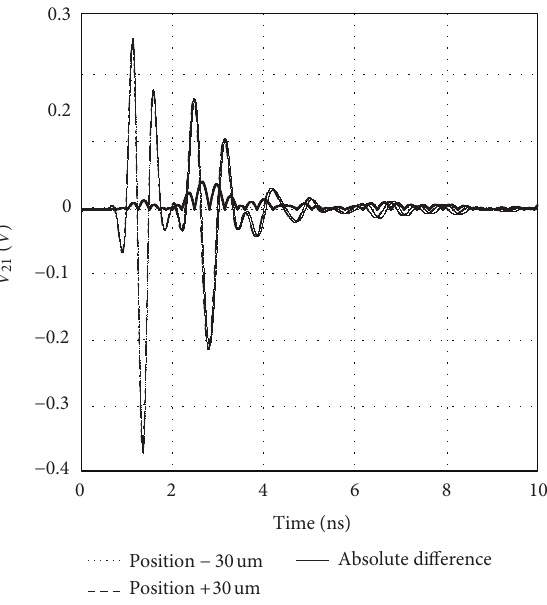
simulated for different displacement between the thorax and the antenna.